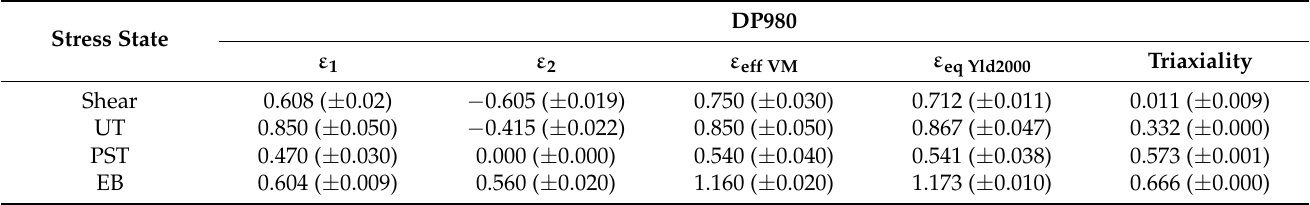
Table A4. Summary of fracture strains for the DP980 AHSS. Note that the von Mises effective strain corresponds to the absolute strain assuming a linear strain path. The Barlat Yld2000 equivalent strain corresponds to the accumulated work-conjugate equivalent strain integrated along the measured strain path and accounts for material anisotropy.